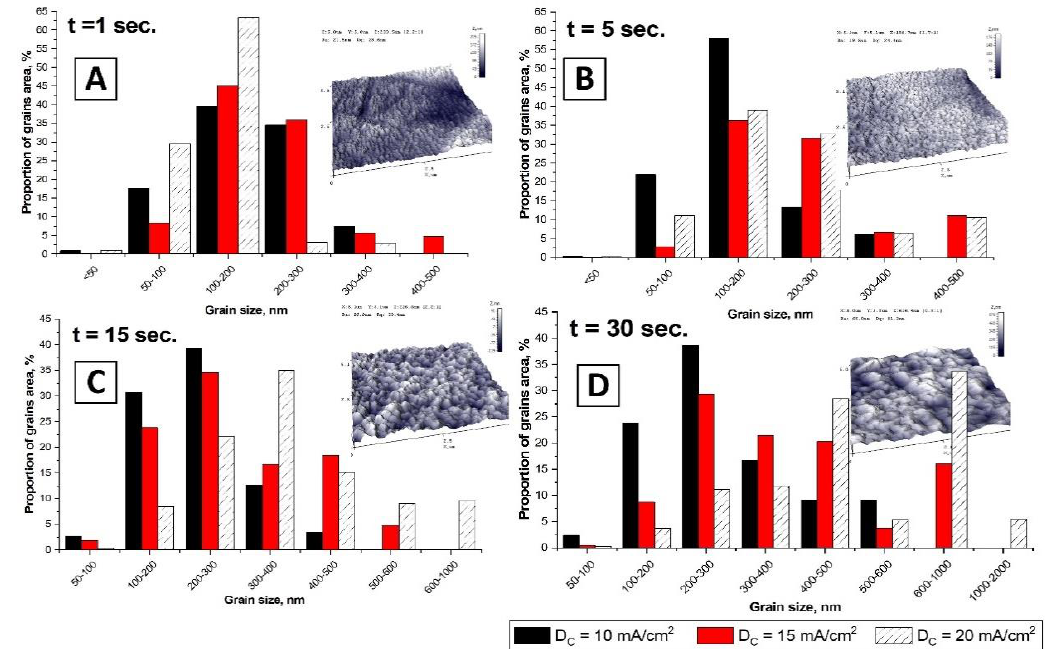
Figure 7. The dependence of the grain size of electrodeposited films on the duration ( A —1 s, B —5 s, С —15 s, D —30 s) in a PE at current densities of 10–20 mA/cm 2 . The insert shows AFM images of the Bi films surface obtained at a current density of 10 mA/cm 2 (scan field size is 5 µm by 5 µm).